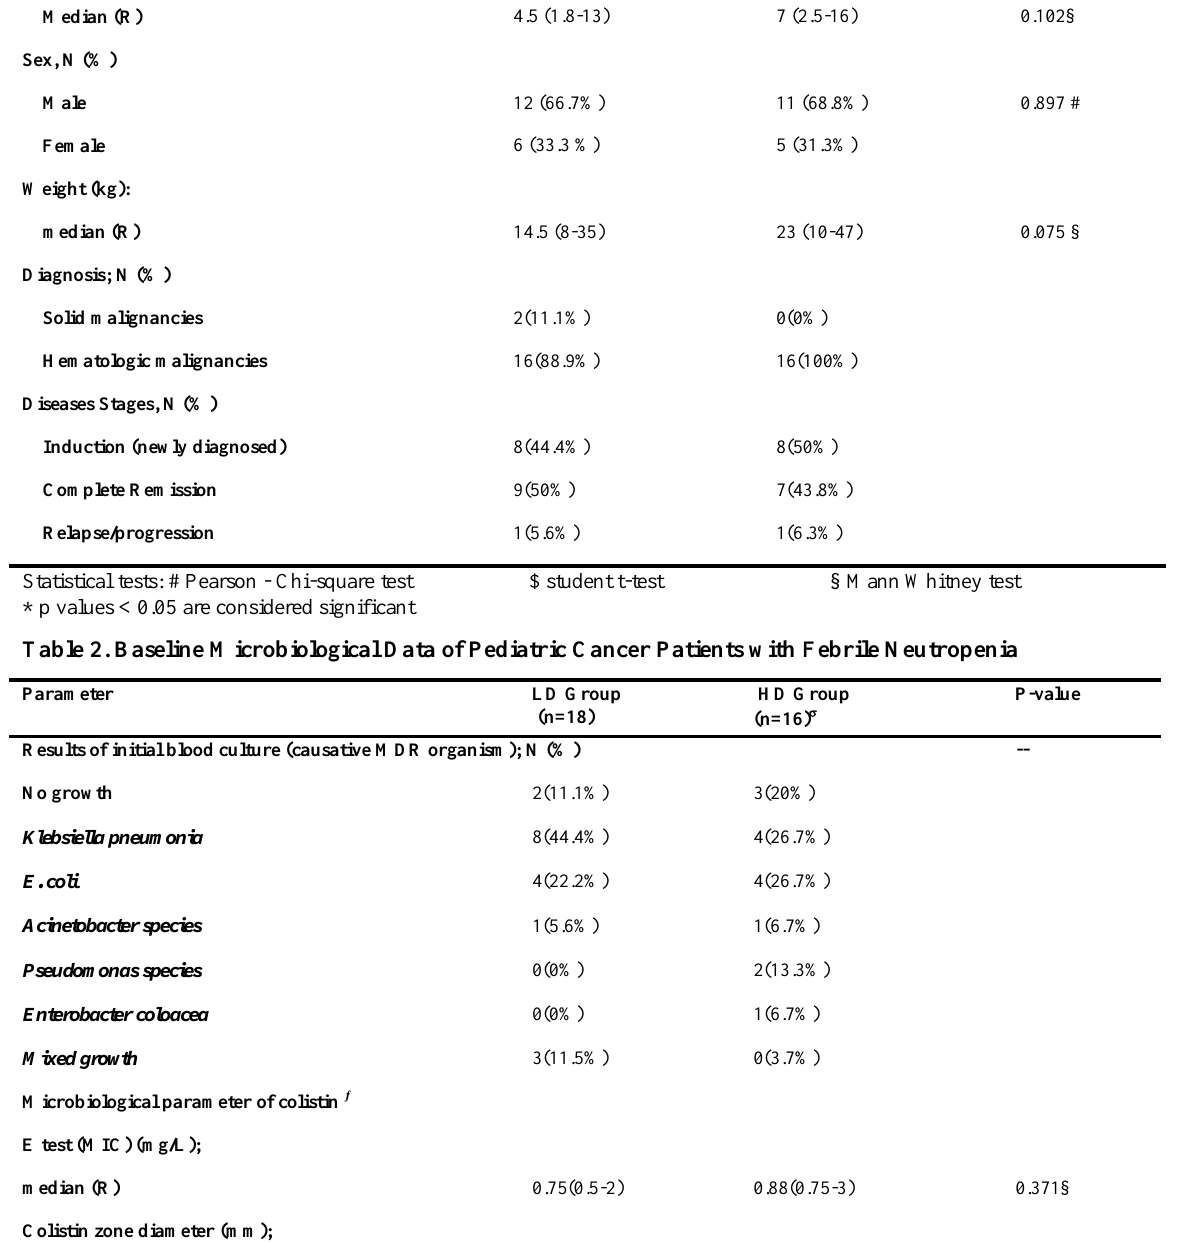
Table 1. Baseline Demographics Characteristics of Pediatric Cancer Patients with Febrile Neutropenia Parameter LD Group HD Group P-value N=18